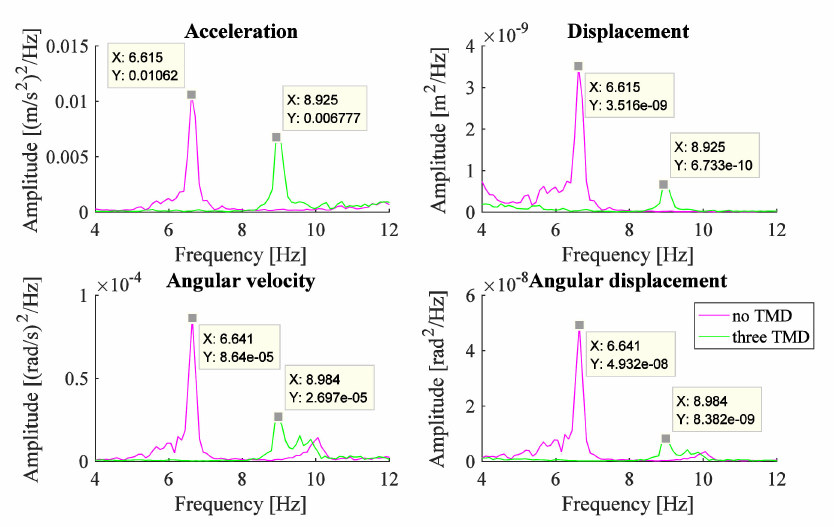
Figure 9. PSD obtained from IMU measurements for the system with three TMDs